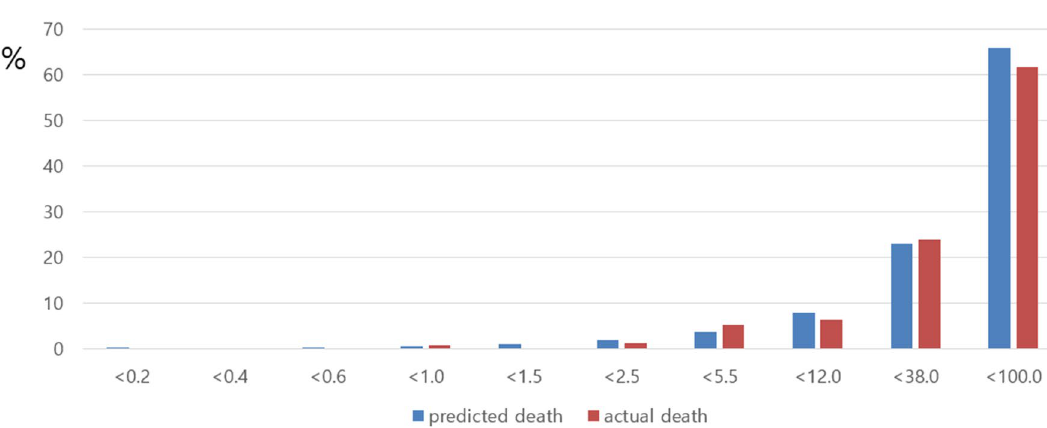
Figure 3. Probability of Predicted and Actual Deaths in validation